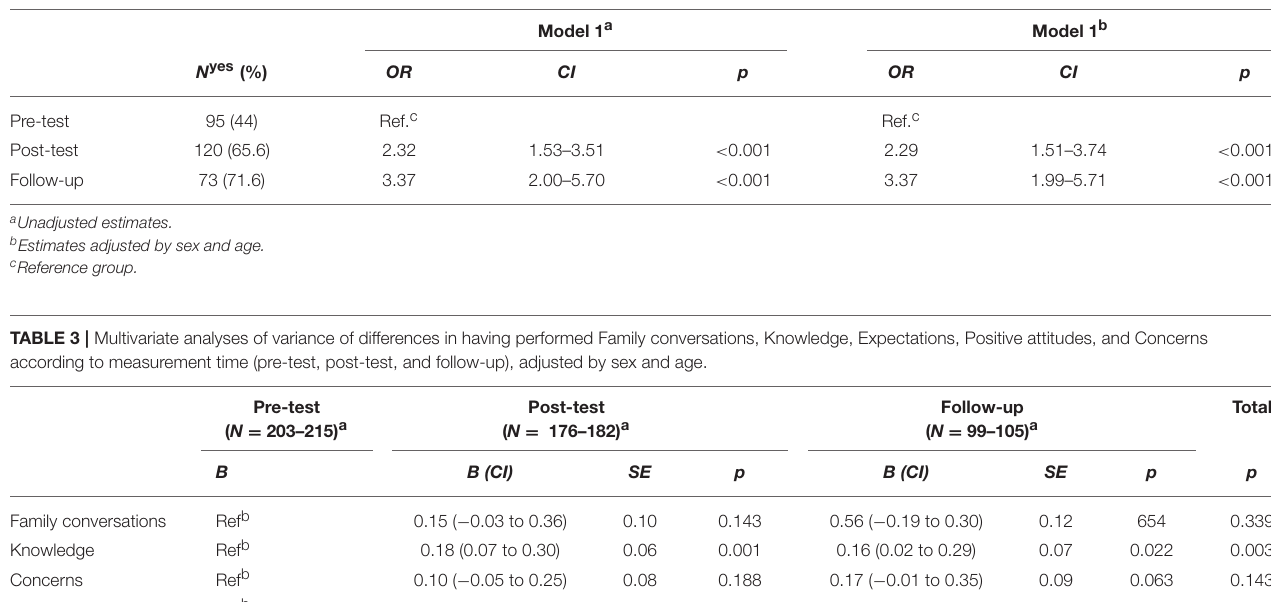
TABLE 2 | Logistic regression analysis of the probability of identification of children of patients according to measurement time (pre-test, post-test and follow-up).